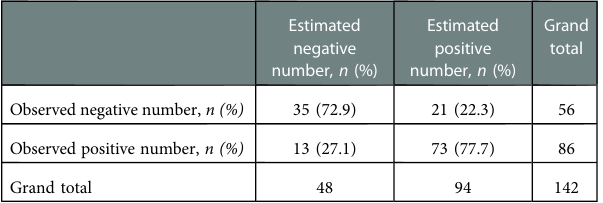
TABLE 4 Cross-classi fi cation table of observed numbers and regression equation estimated